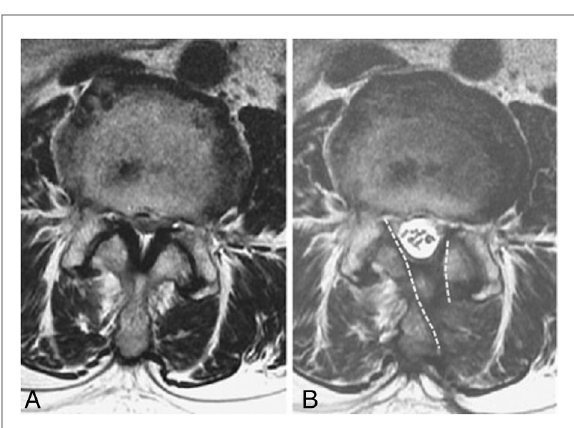
FIGURE 3 Preservation of facet joint. ( A ), pre-operative and ( B ), post-operative facet joint preservation. Dashed line: the extent of